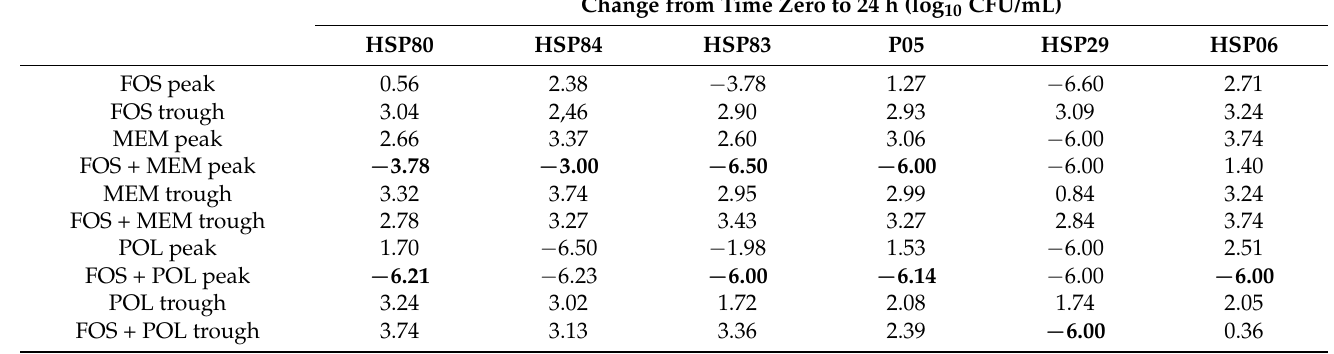
Table 3. TKA results showing the growth rates for six representative isolates between time zero and 24